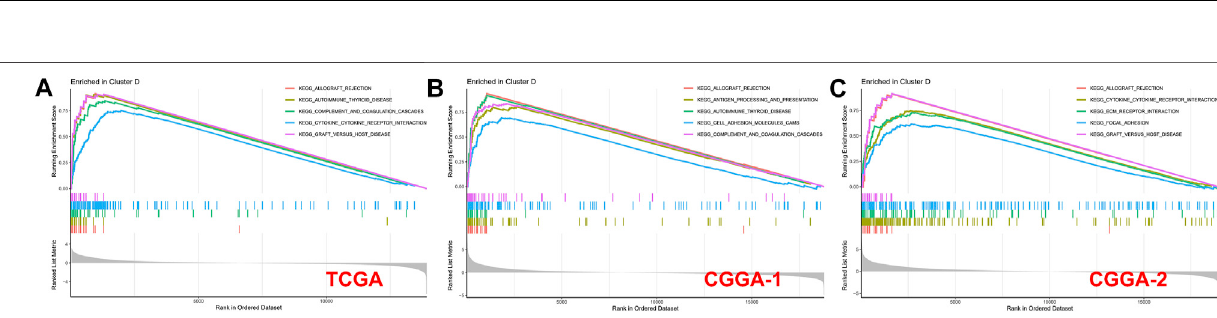
Frontiers in Genetics |